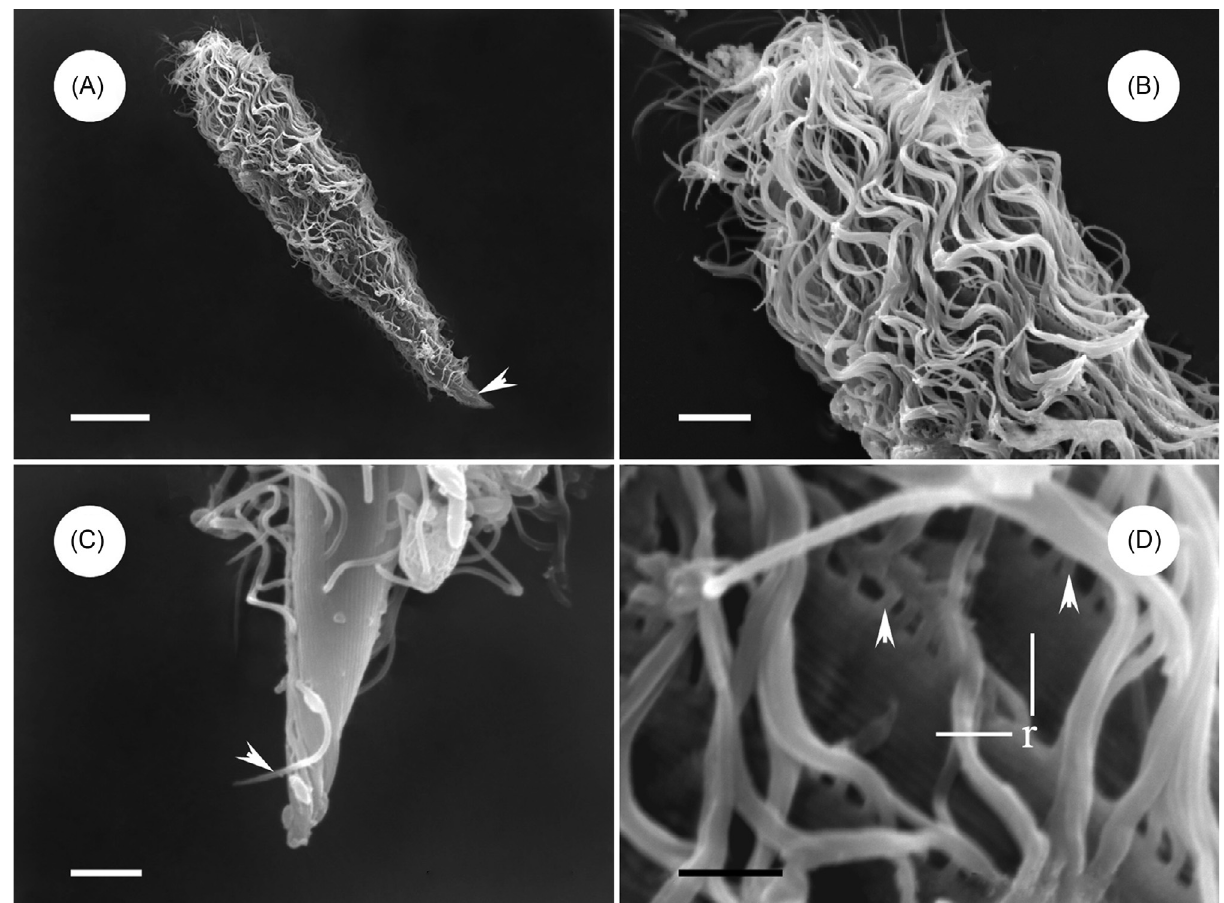
Figure 1. Scanning electron microscope images of Protoopalina pingi Nie, 1935. (A) Overview of P. pingi , showing many fused flagella over the body. Scale bar = 20 l m. (B) Anterior end of P. pingi , showing the densely flagellated body surface. Scale bar = 5 l m. (C) Caudal tip of P. pingi , showing the flagella (arrowhead) in the region barren of flagella. Scale bar = 2.5 l m. (D) The flagella are arranged in the ridge, showing the proximal ends of the flagella (arrowhead) and ridge ( r ). Scale bar = 1.5 l